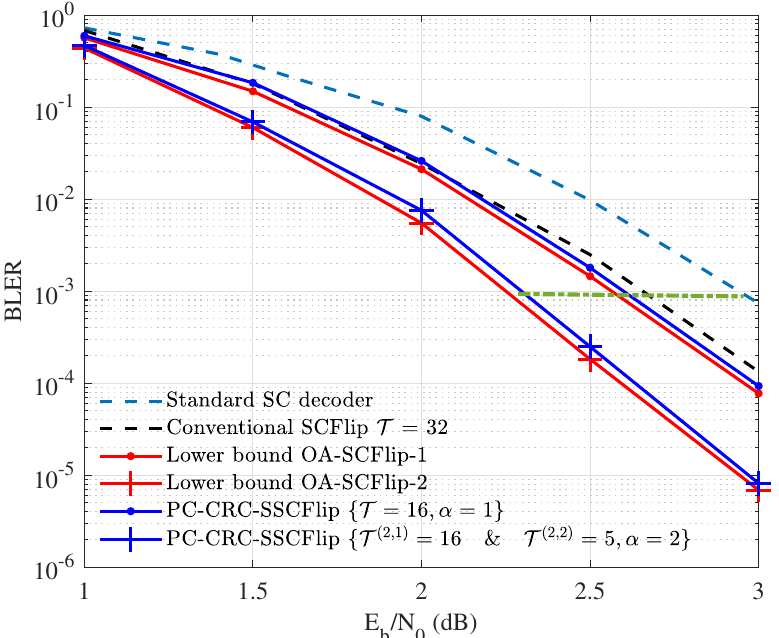
Figure 7. BLER performance comparison of the PC-CRC-SSCFlip decoder with SC, SCFlip, and OA-SCFlip decoders for P ( 1024,512 ) with 24 check bits.